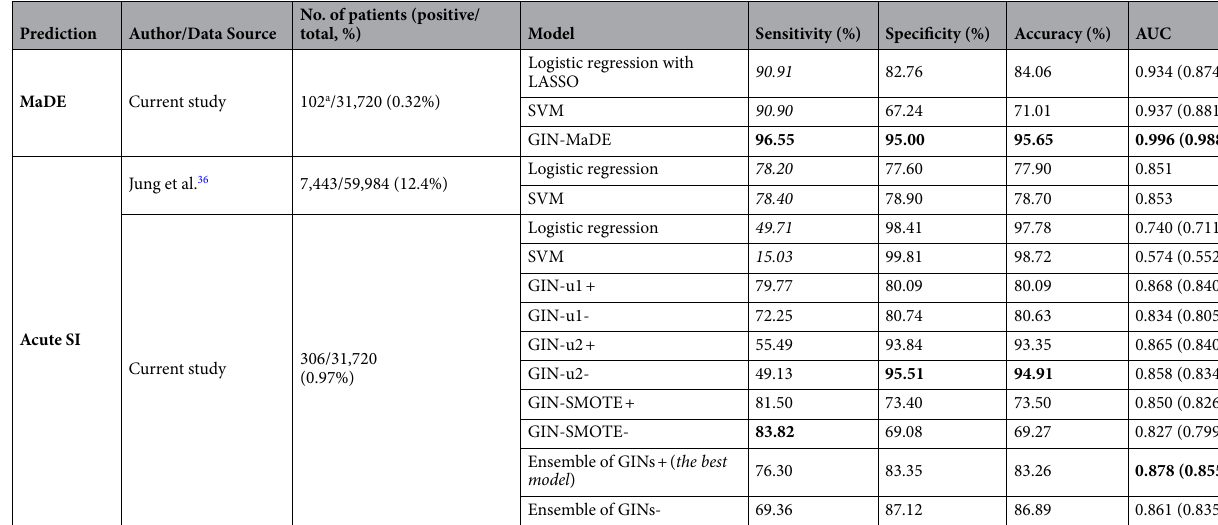
Table 1. Model performance for prediction of major depressive episodes (MaDE) and acute suicidal ideation (SI): model comparison with external validation. Bold numbers indicate the best metrics among graph neural network models. Italic numbers indicate lower sensitivity of logistic regression, and SVM models. a A total of 358 people received structured interviews, of which 102 participants were diagnosed with MaDE, accounting for 0.32% of the total 31,720 participants. The results from a state-of-the-art study by Jung et al. 36 were cited, for which the confidence intervals of AUC were not reported. In the case of GIN for acute SI, metrics were provided from a dataset both including (e.g., GIN-u1 +) and excluding (e.g., GIN-SMOTE-) Item-9 of PHQ- 9. MaDE major depressive episode, SI suicidal ideation, AUC area under the curve, LASSO least absolute shrinkage and selection operator, SVM support vector machine, GIN graph isomorphism